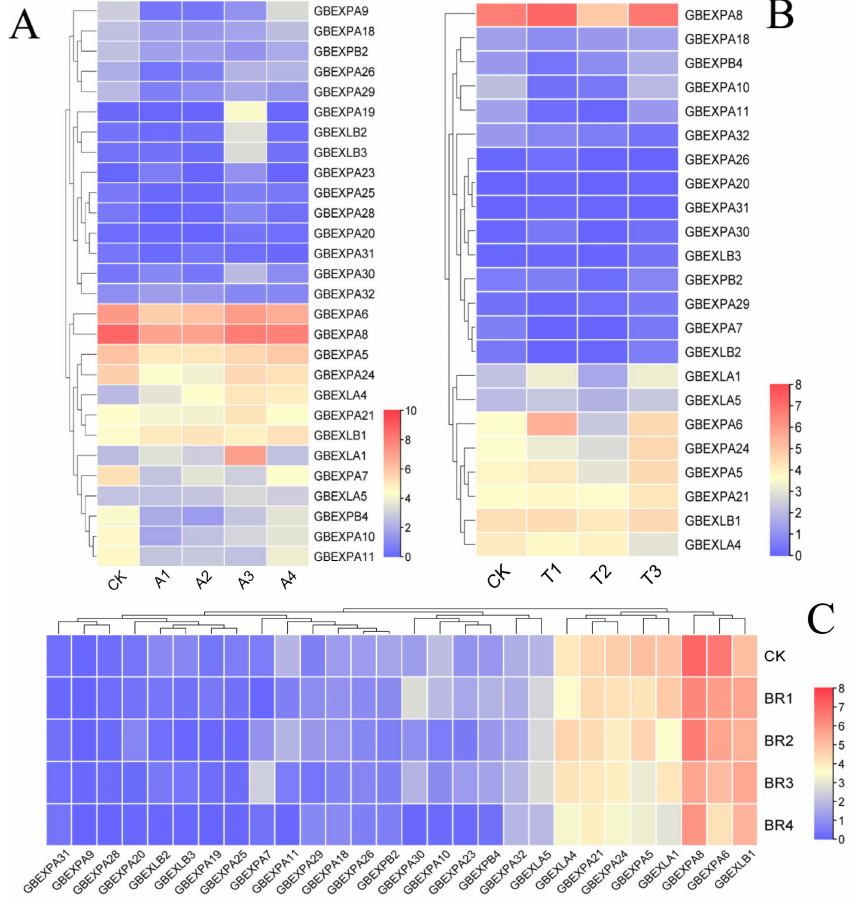
Figure 7. Expression profiles of GbEXPs under exogenous ABA, SA, and BR treatments. Transcript abundance TPM values were transformed into log2(TPM + 1) to construct heatmaps. ( A ) GbEXPs ex- pression under induction of ABA. ( B ) GbEXPs expression under exogenous SA spraying. ( C ) GbEXPs expression under exogenous